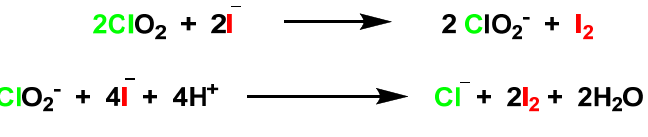
Figure 25. ClO 2 oxidizes to I − to I 2 .